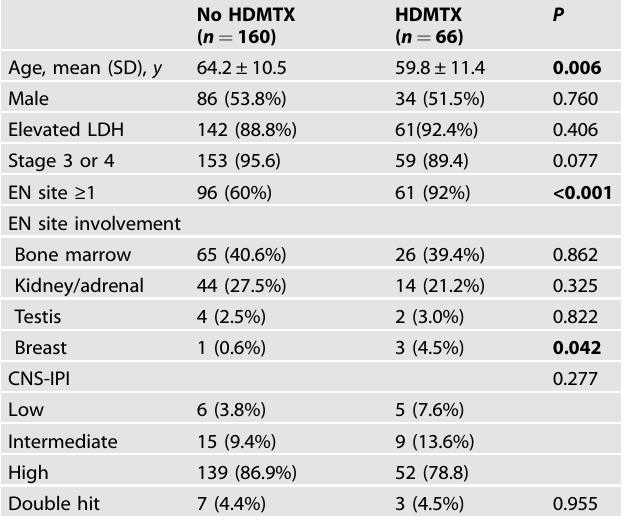
Table 2. Baseline patient characteristics by treatment group.